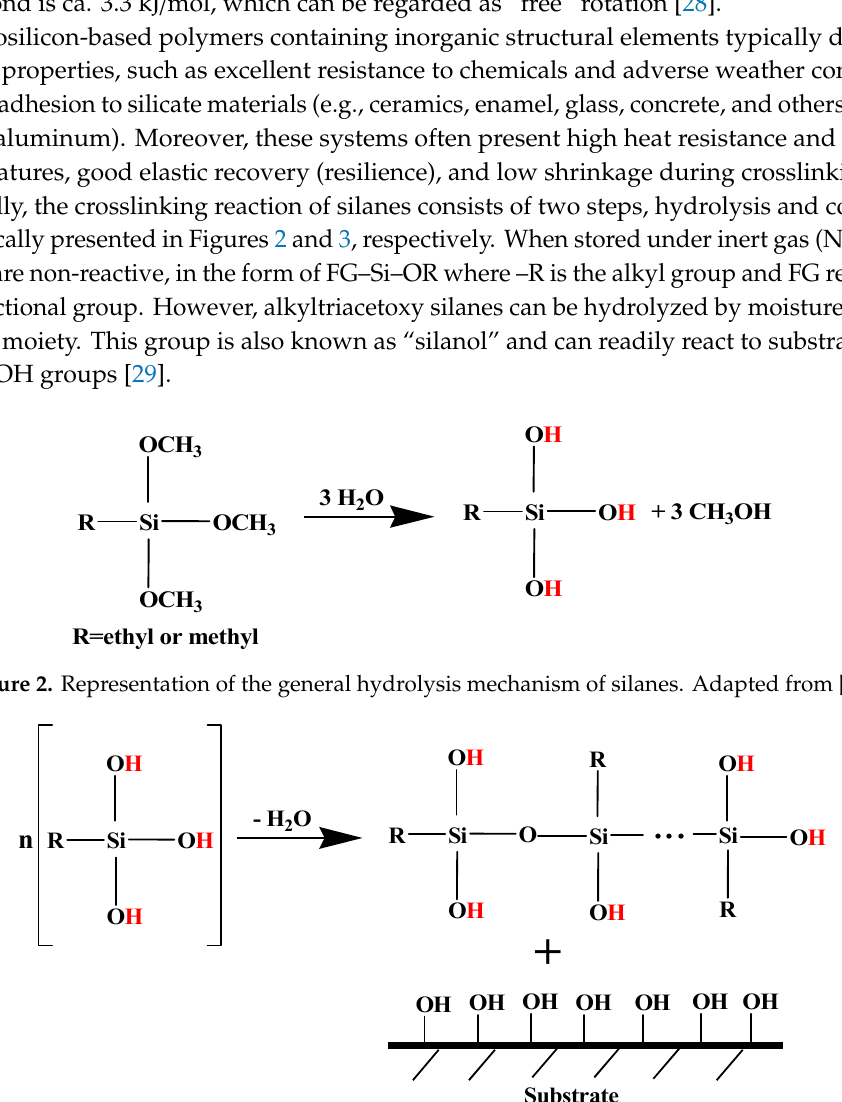
Figure 3. Representation of the typical condensation mechanism of silanes. Adapted from [30].